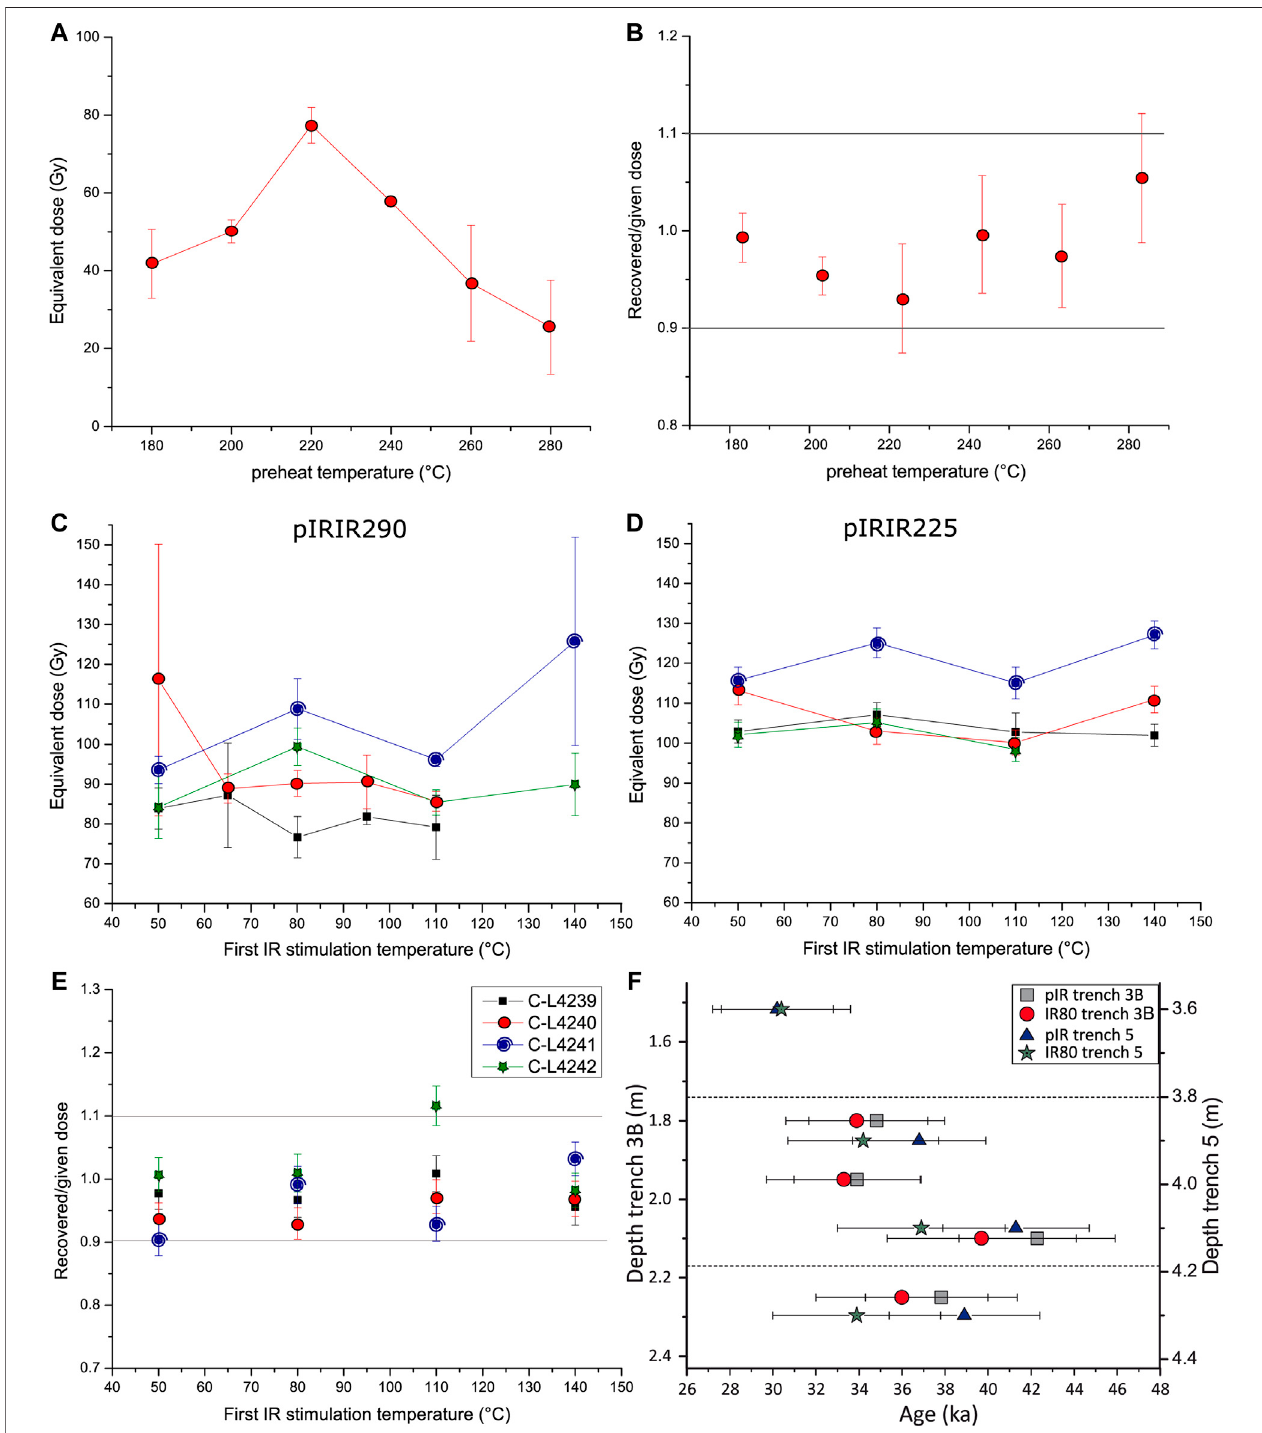
FIGURE 5 | Luminescence dating results from Crvenka-At. Preheat plateau test (A) and dose recovery test (B) of the quartz fraction of sample C-L4240; fi rst IR stimulationtemperature testsusingthepIRIR 290 (C) andpIRIR 225 (D) protocols,doserecoverytest (E) ofthefeldsparfractionsofsamplesC-L4239 – C-L4242,andage- depth plot showing the age data of the pIRIR 225 and the IR 80 signals of all samples (F) .